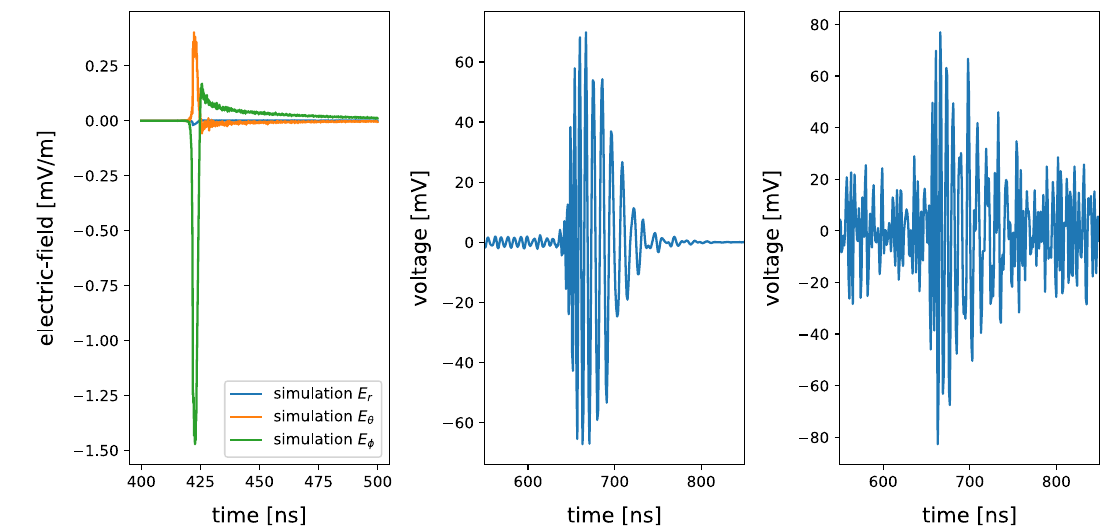
Fig. 5 The simulated electric-field traces (left), voltage trace in a channel resulting from full detector simulation (middle) and with noise added (right)